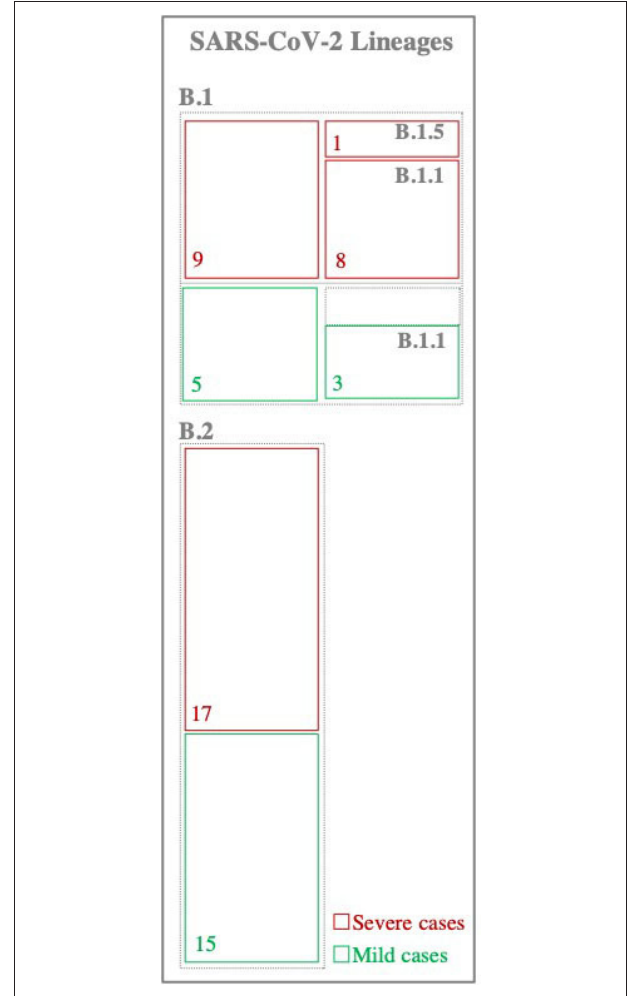
FIGURE 1 | Classification of SARS-CoV-2 viruses. Viruses were classified based on the lineage nomenclature system proposed in Rambaut et al. (2020). Numbers inside the boxes represent the total number of samples within each